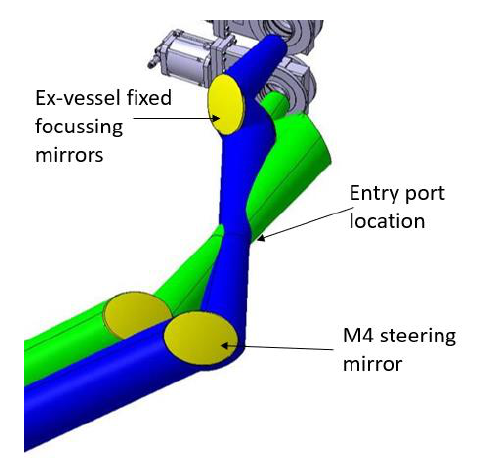
Fig. 4. Off-axis launcher geometry showing four mirror system with beams crossing through the entry port into the vessel